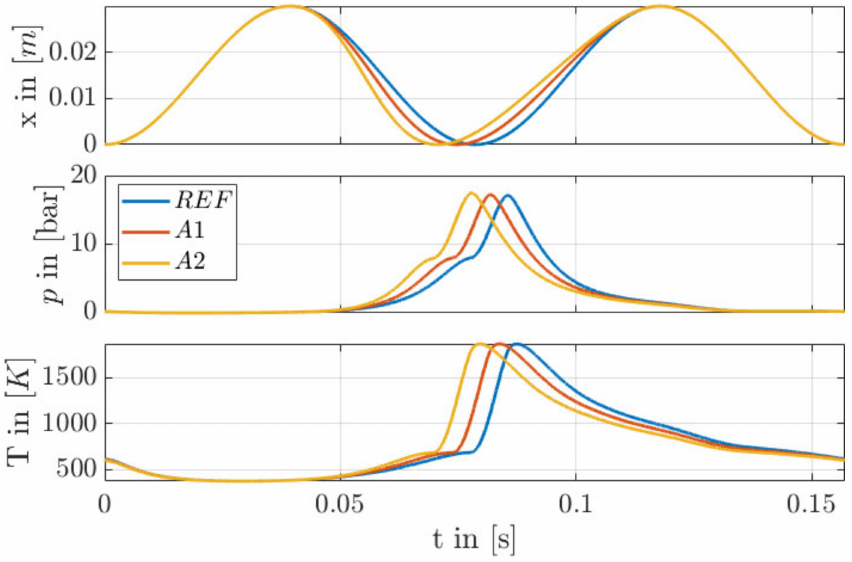
Figure 15. Comparison of trajectories REF, A1 and A2 related to the energy conversion of the internal combustion engine: illustration of the stroke, cylinder pressure and temperature depending on time.